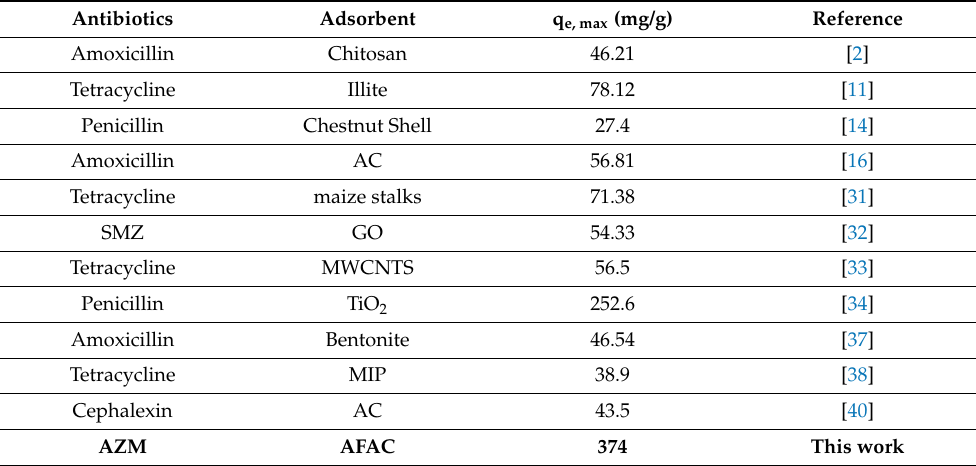
Figure 5. The adsorption data fitted to the Freundlich isotherm in ( a ) nonlinear form, ( b ) linear form, and ( c ) model predicted versus measured capacity at different temperatures. The blue and red lines in ( c ) represent the ± 15% limit. Conditions: pH = 9, C 0 = 100 mg/L, and time = 75 min. Table 3. The comparison of different adsorption